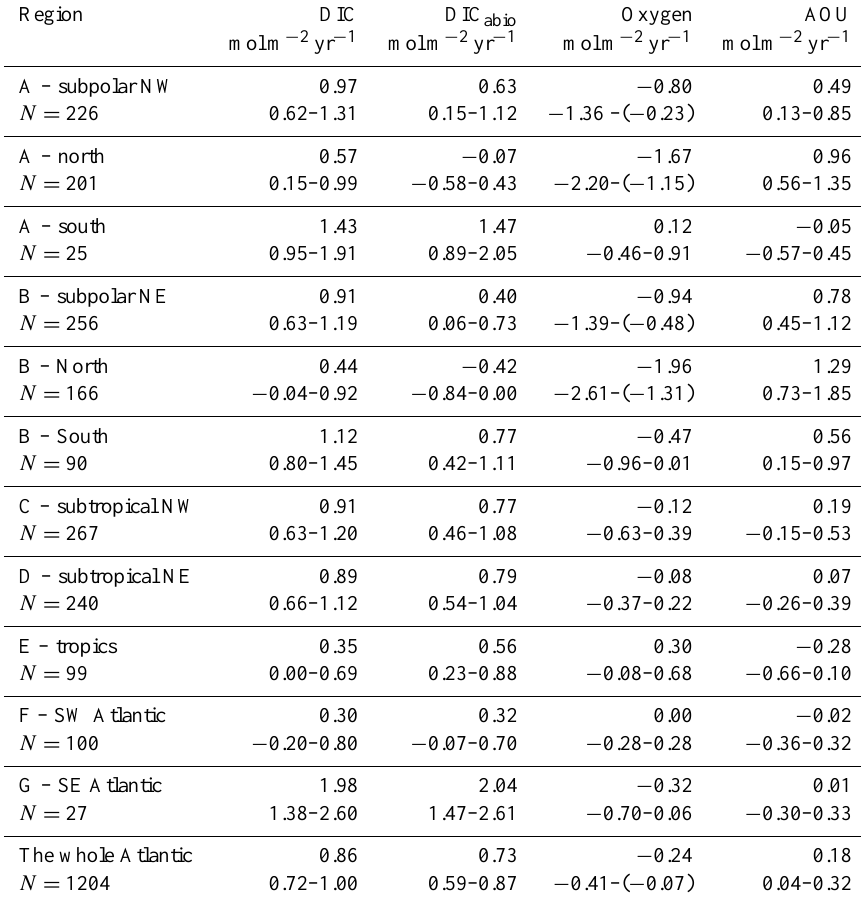
Table 1. Averaged storage rates of DIC, DIC abio , Oxygen and AOU for the 7 regions (see Figs. 2–5) and for the whole Atlantic as described in the text. The top row of each cell gives the average storage rates of the 2 ◦ × 2 ◦ bins within each region; the bottom line in each cell gives the 95% confidence interval. The number of samples (i.e. station pairs, N ) for each area is indicated in the left